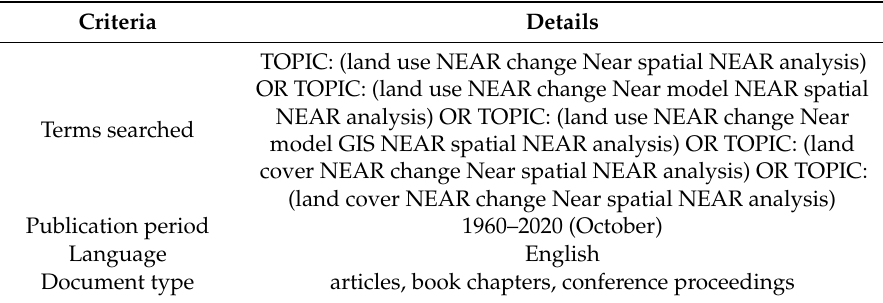
Table 1. Data collection criteria.